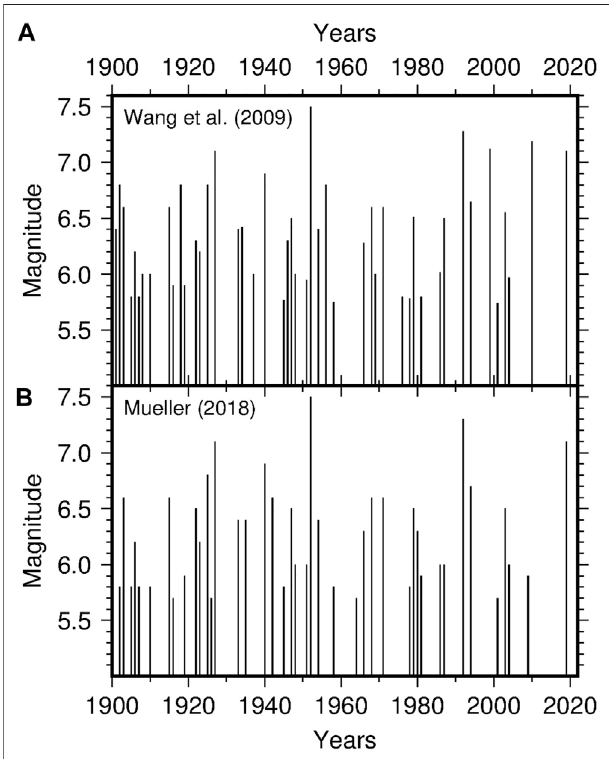
FIGURE 2 | Magnitude/time distribution of the earthquakes considered in this